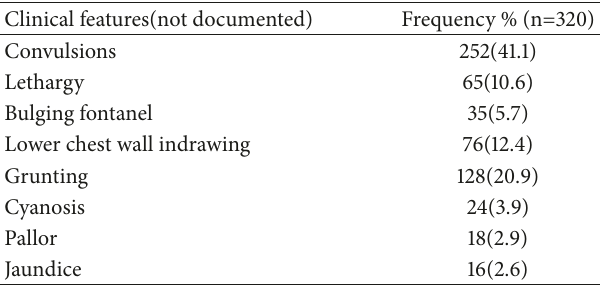
Table 2: Audit of documentation of clinical